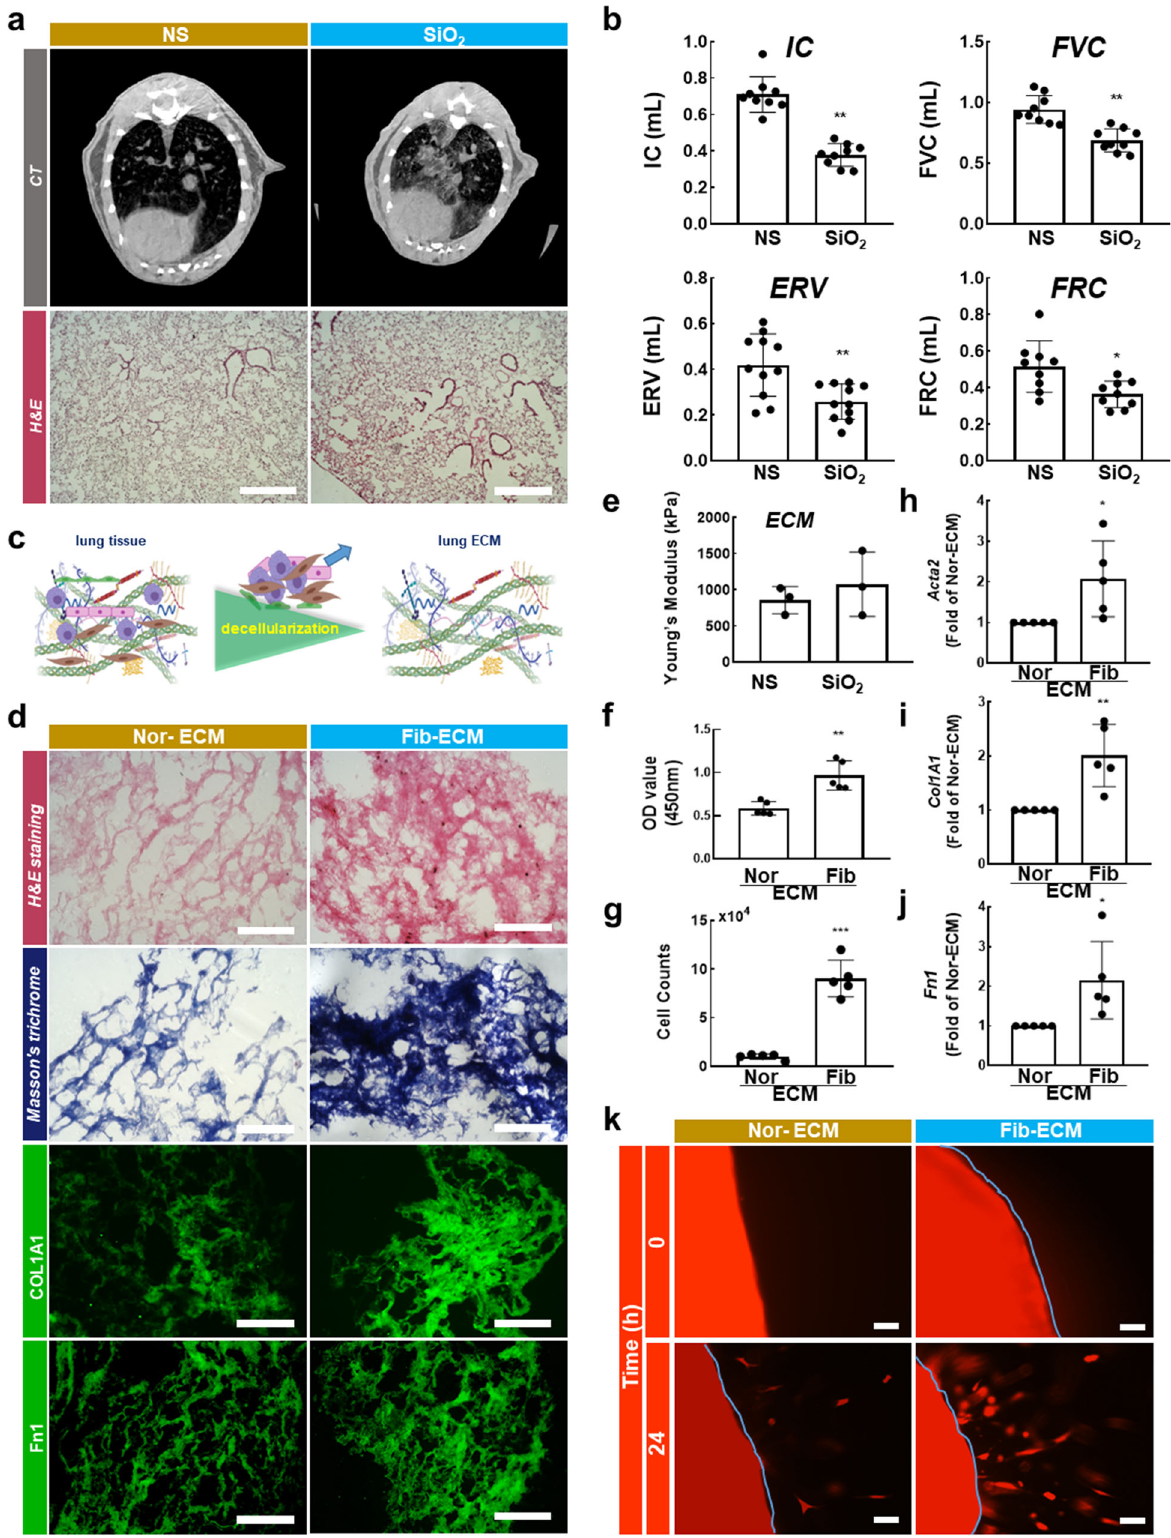
fi brotic ECM increased α -SMA, collagen I, and fi bronectin mRNA expression levels in fi broblasts (Fig. 1h – j). In addition, fi brotic ECM promoted fi broblast migration (Fig. 1k, Supplementary Fig. 2c, d). All of the above mentioned experimental results indicated that the fi brotic ECM in fl uences normal fi broblast function, thus leading to PF aggravation.